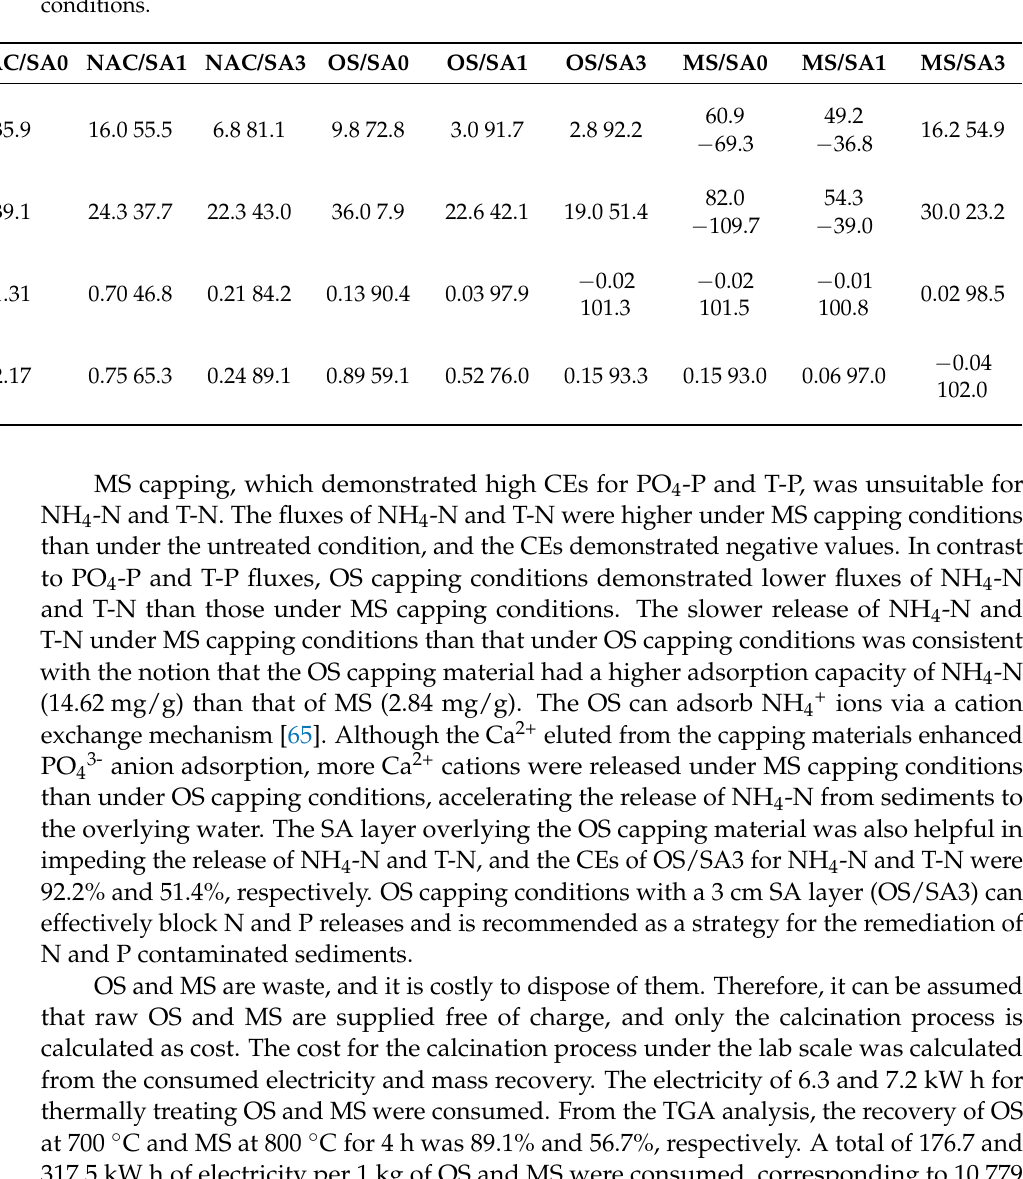
Table 3. Nutrient fluxes (mg/m 2 d) and capping efficiency (CE) (%) under uncapped and capped